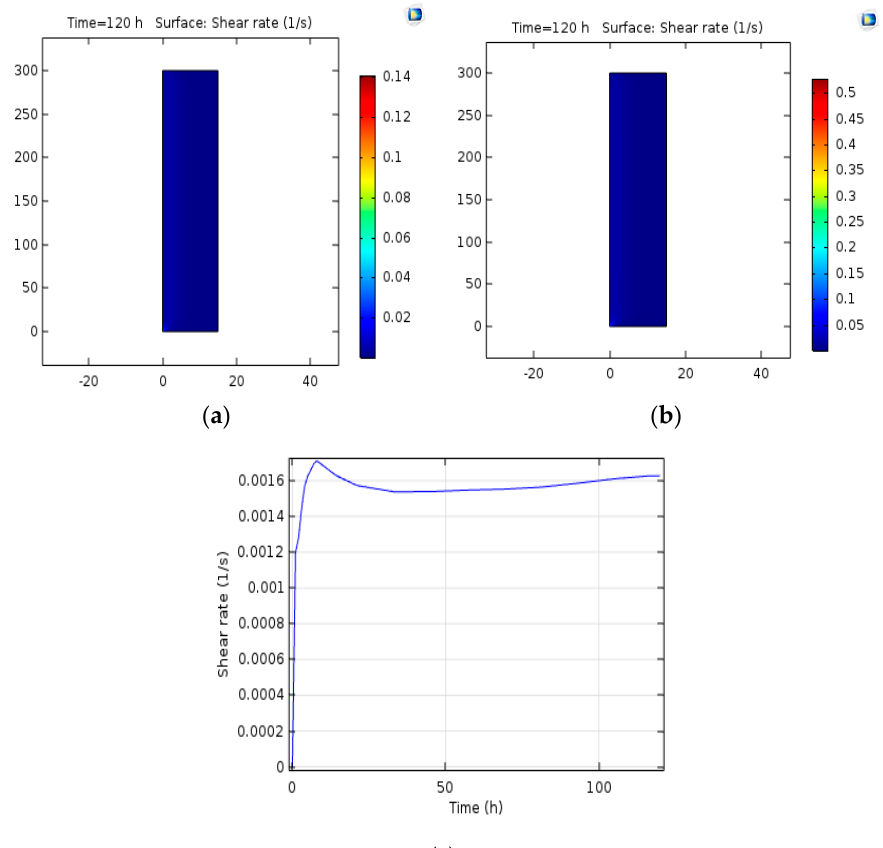
Figure 12. ( a ) The stress rate at the gas input velocity of 0.015 m/s. ( b ) The stress rate at the gas input velocity of 0.055 m/s. ( c ) The stress rate over time.